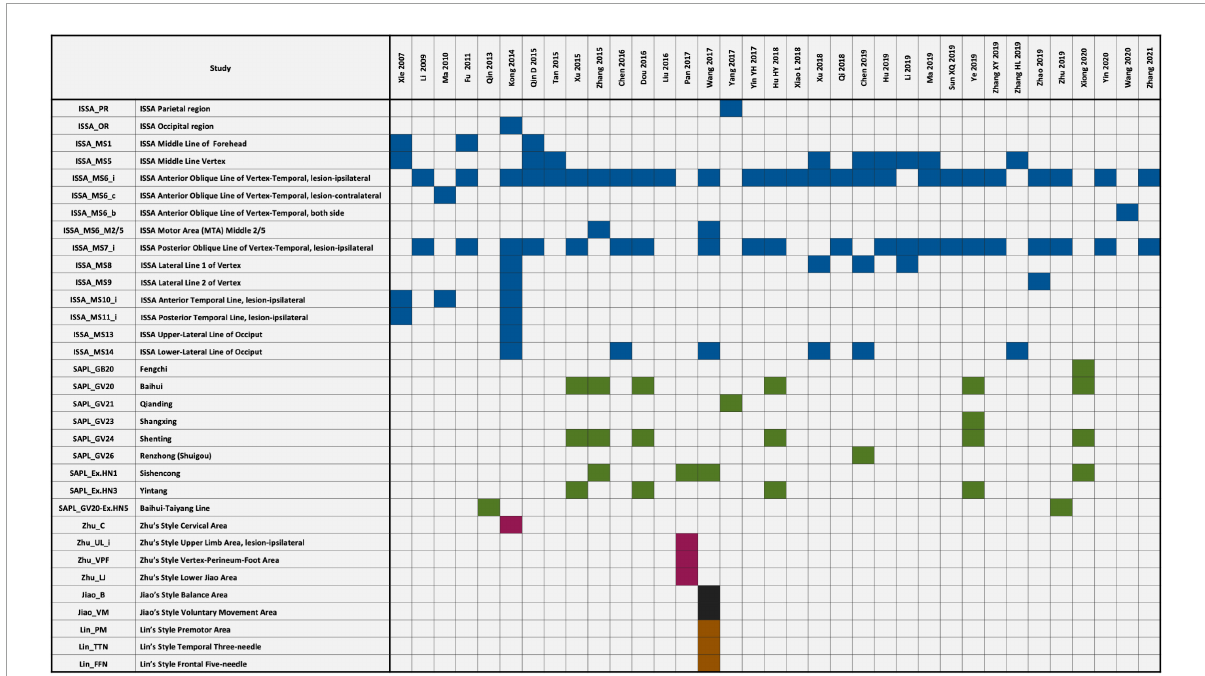
FIGURE2 Scalp acupuncture (SA) locations used in the included studies. The full names and the abbreviations of the scalp acupuncture (SA) location used in the association rule analysis are listed in the left panel. The SA locations used in the included studies are shown with filled color in the right panel. Blue: International Standard Scalp Acupuncture (ISSA). Green: WHO Standard Acupuncture Point Locations (SAPL). Pink: Zhu’s style SA. Black: Jiao’s style SA. Brown: Lin’s style SA.